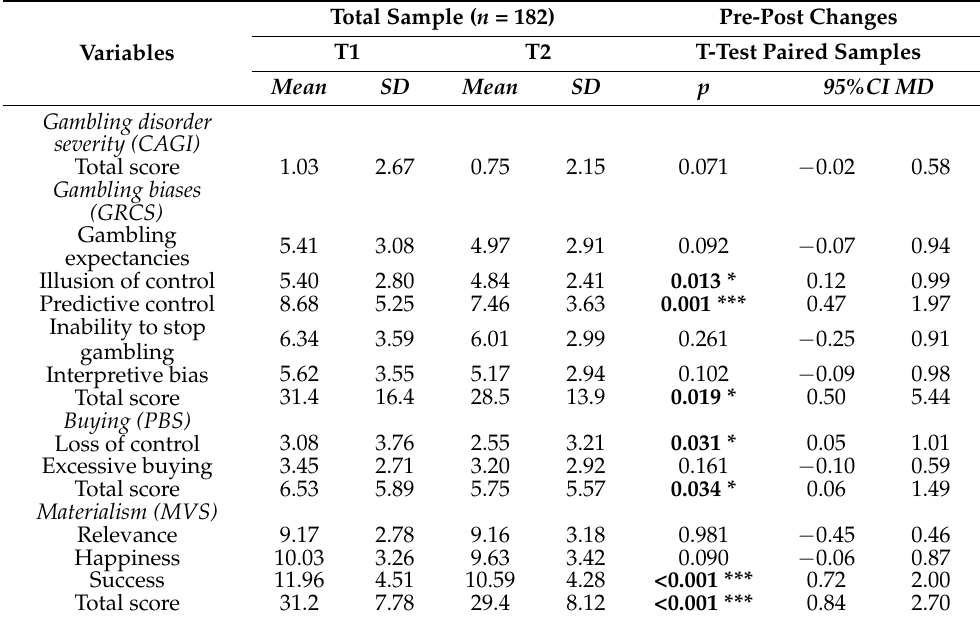
Table 1. Changes between Time 1 and Time 2 for the measures of the study. Total Sample ( n = 182) Pre-Post Changes T1 T2 T-Test Paired Samples Variables